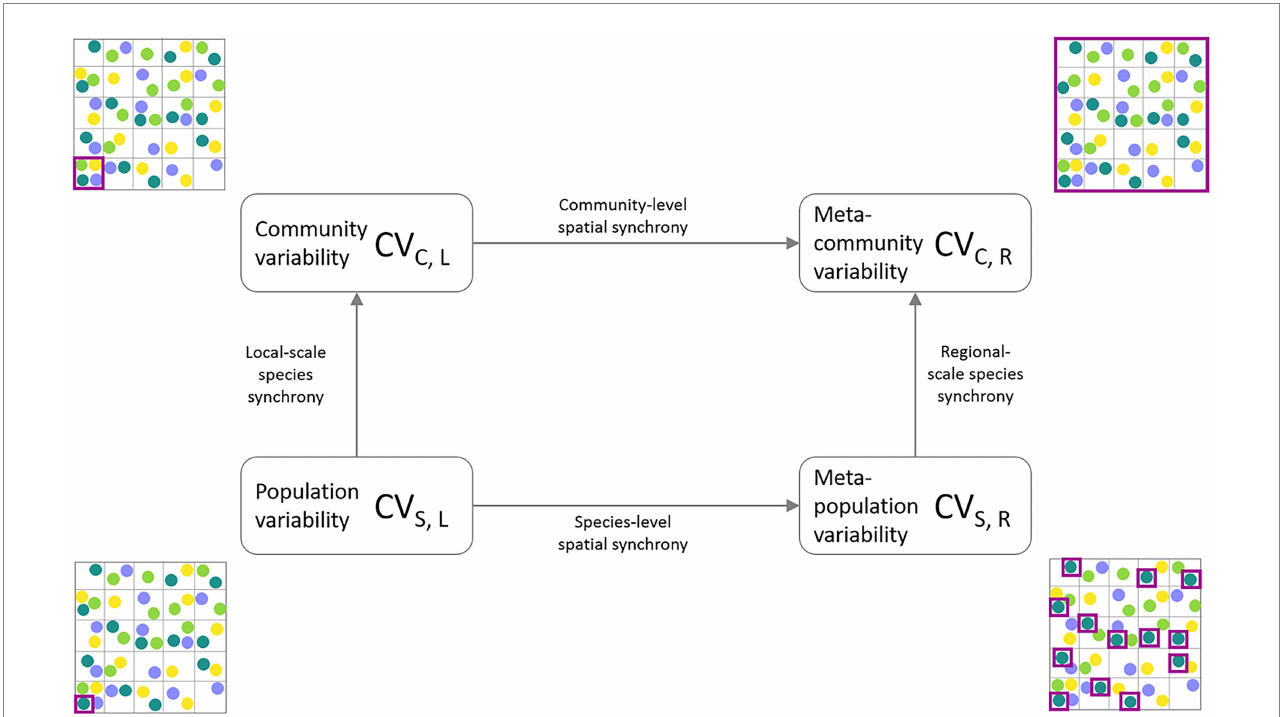
FIGURE 1 Partitioning framework of meta-community temporal biomass variability (coefficient of variation, CV) into lower levels of spatial scale (local, regional) and ecological organization (species, community). The lowest level of aggregation is represented by average species population variability (CV S,L , bottom-left corner). The intermediate level of ecological organization is the average community variability (CV C,L , top-left corner). Spatial aggregation of population variability results in spatially averaged meta-population variability (CV S,R , bottom-right corner). Meta-community variability (CV C,R , top-right corner) represents the temporal variability of the total community biomass across the sampling region. The purple squares indicate at which level biomass measurements are aggregated before calculating and averaging the CVs across the entire study